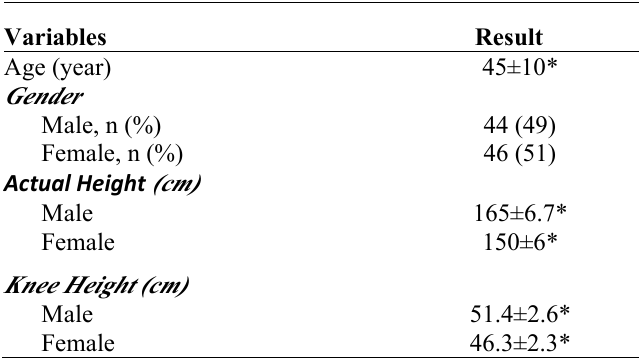
Table 2 Distribution of patients ’ age, actual height, and knee height (n=90) Variables Result